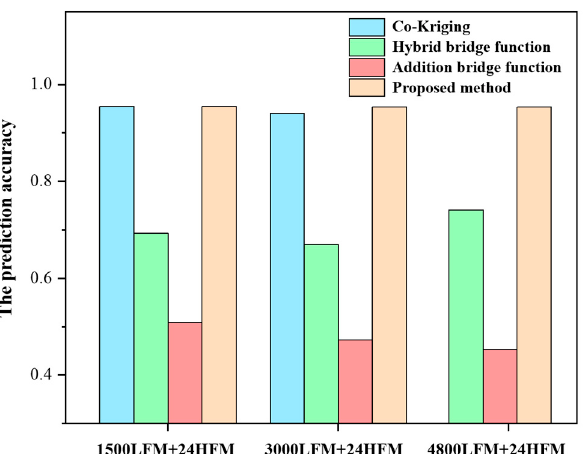
Figure 7. The prediction accuracy of the various digital twin models for the hierarchical stiffened plate at 18 kN.